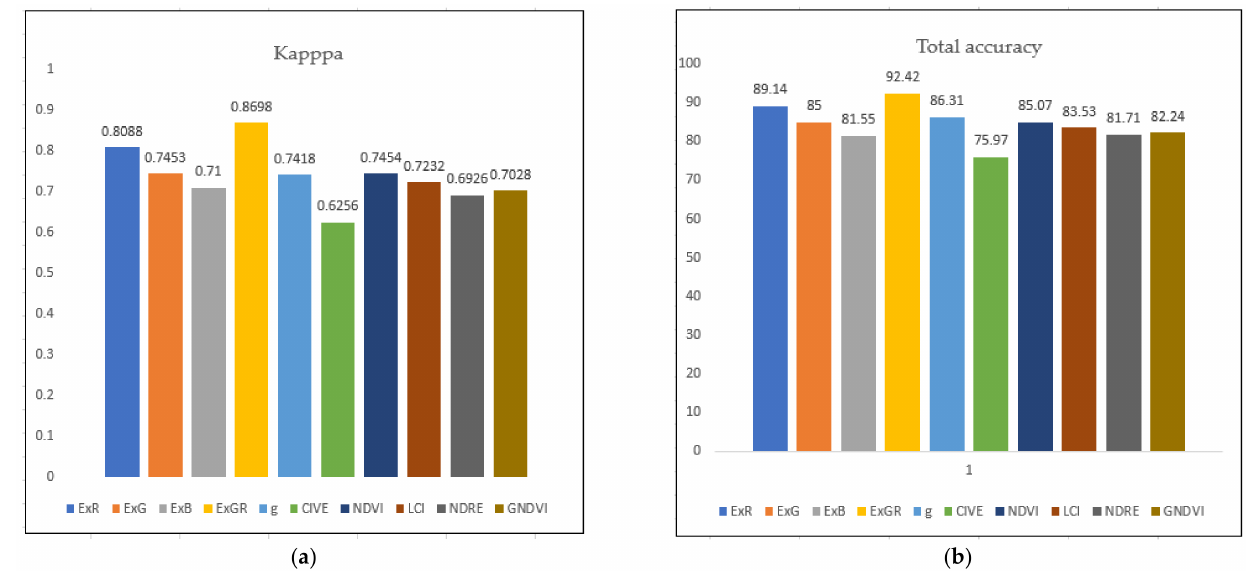
Figure 10. Accuracy comparison of the object-oriented classification methods for the ten vegetation indexes: ( a ) Kappa coefficient comparison; ( b ) Total accuracy